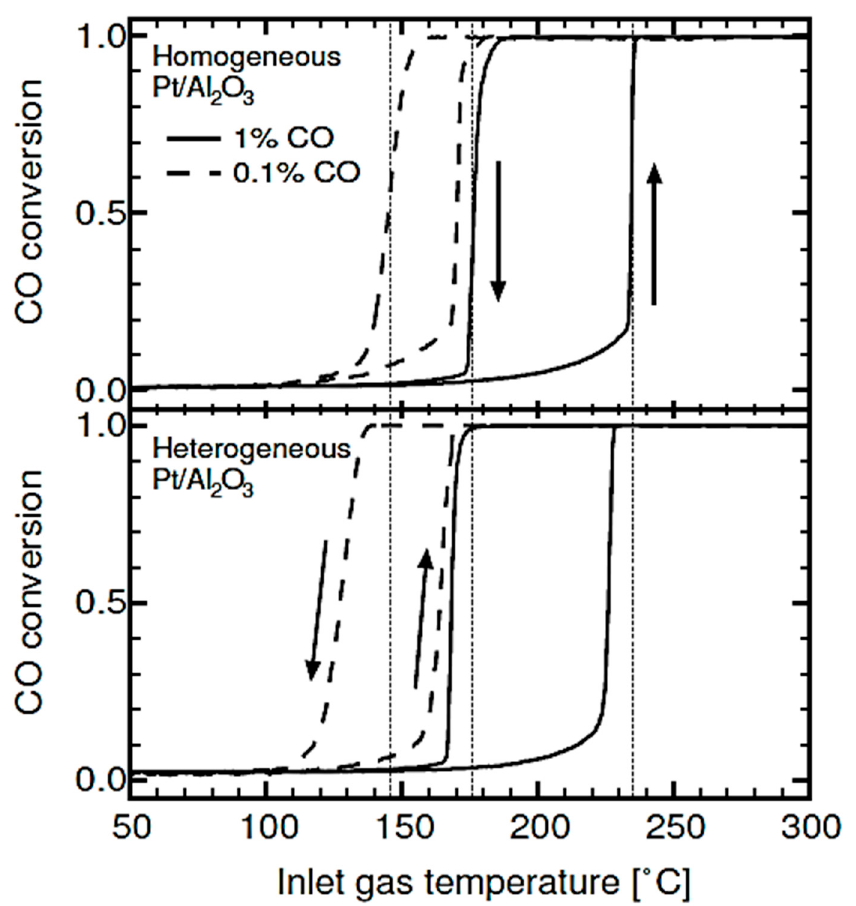
Figure 5. Temperature-programmed oxidation of 0.1 and 1% CO with 9% O 2 over homogeneous (top panel) and heterogeneous (bottom panel) Pt/Al 2 O 3 monolith catalysts using heating/cooling rates of 5 °C/min [5].